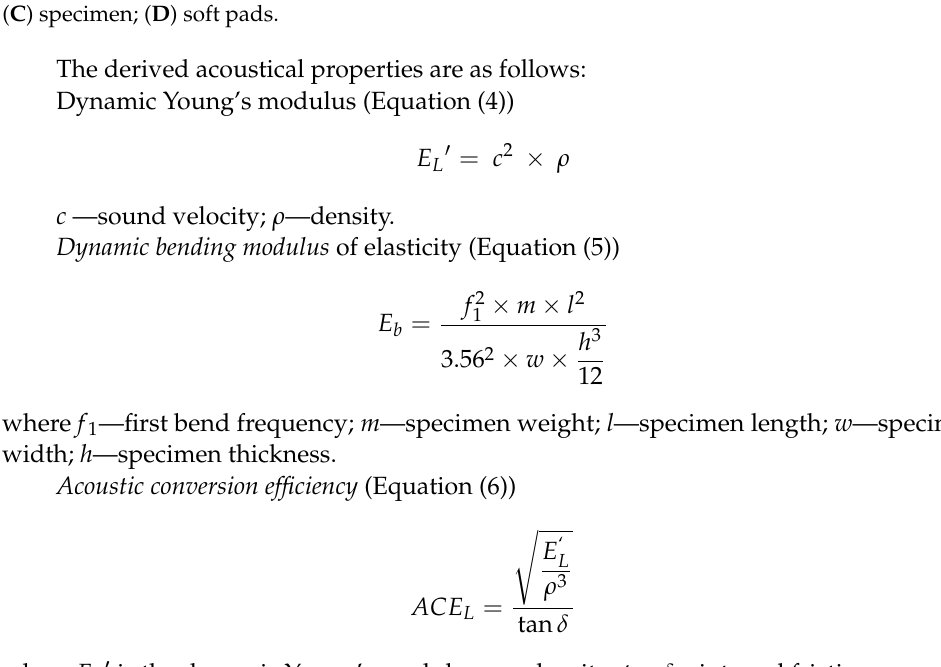
Figure 3. Measuring the acoustical properties: ( A ) soft hammer; ( B ) ultrasonic sensor or microphone; ( C ) specimen; ( D ) soft pads.